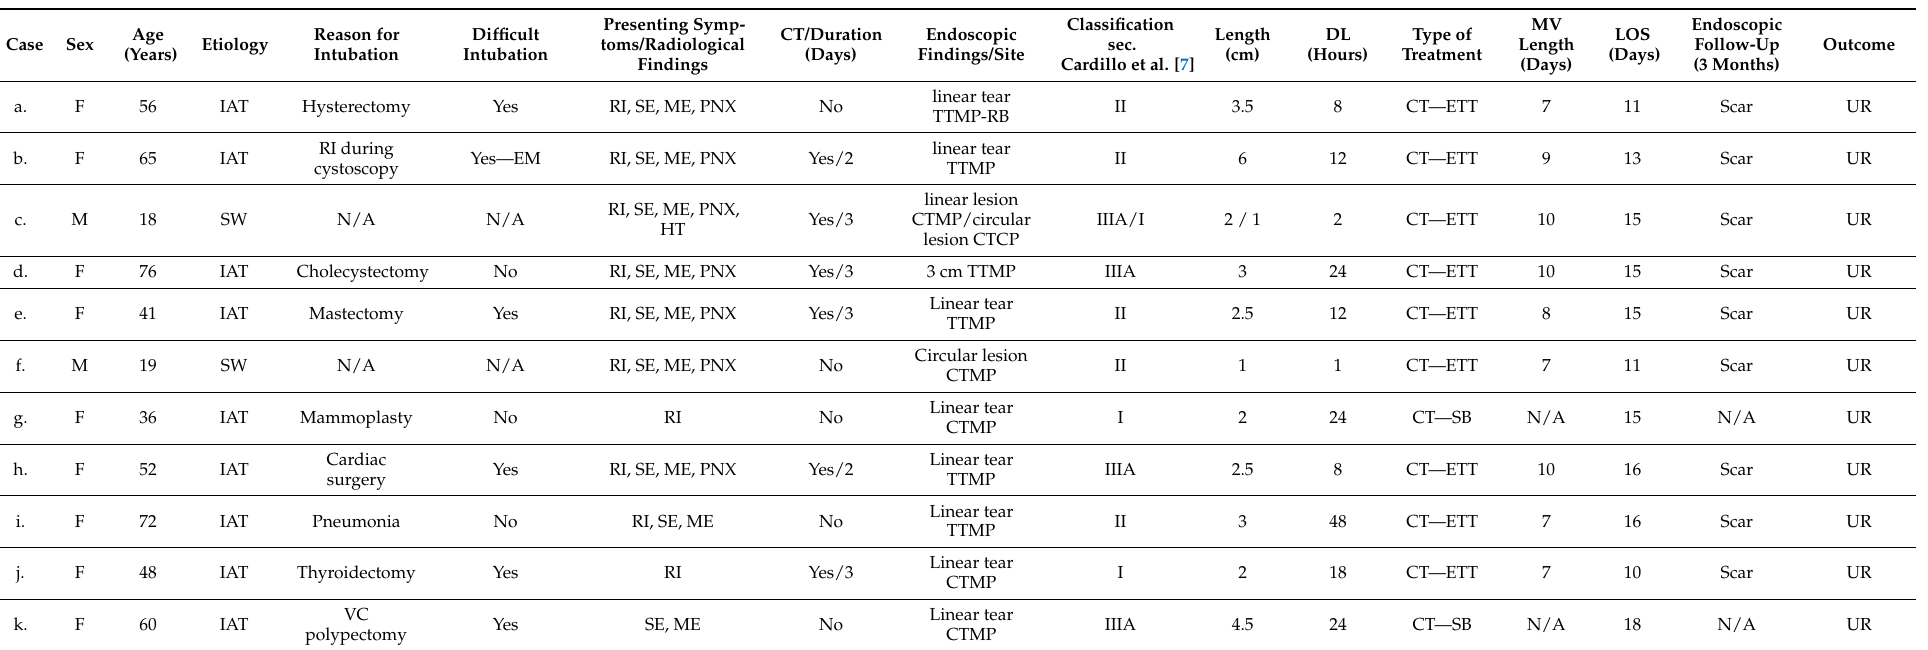
Table 2. Patients’ characteristics, endoscopic findings, and